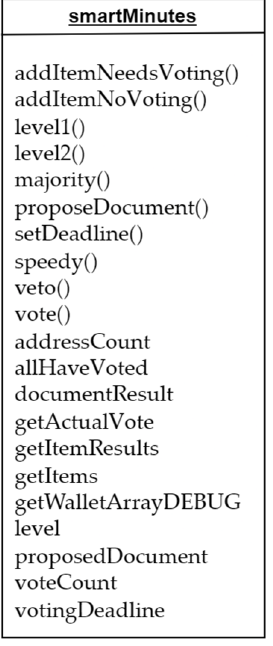
Figure 5. smartMinutes operations. Figure 5. SmartMinutes